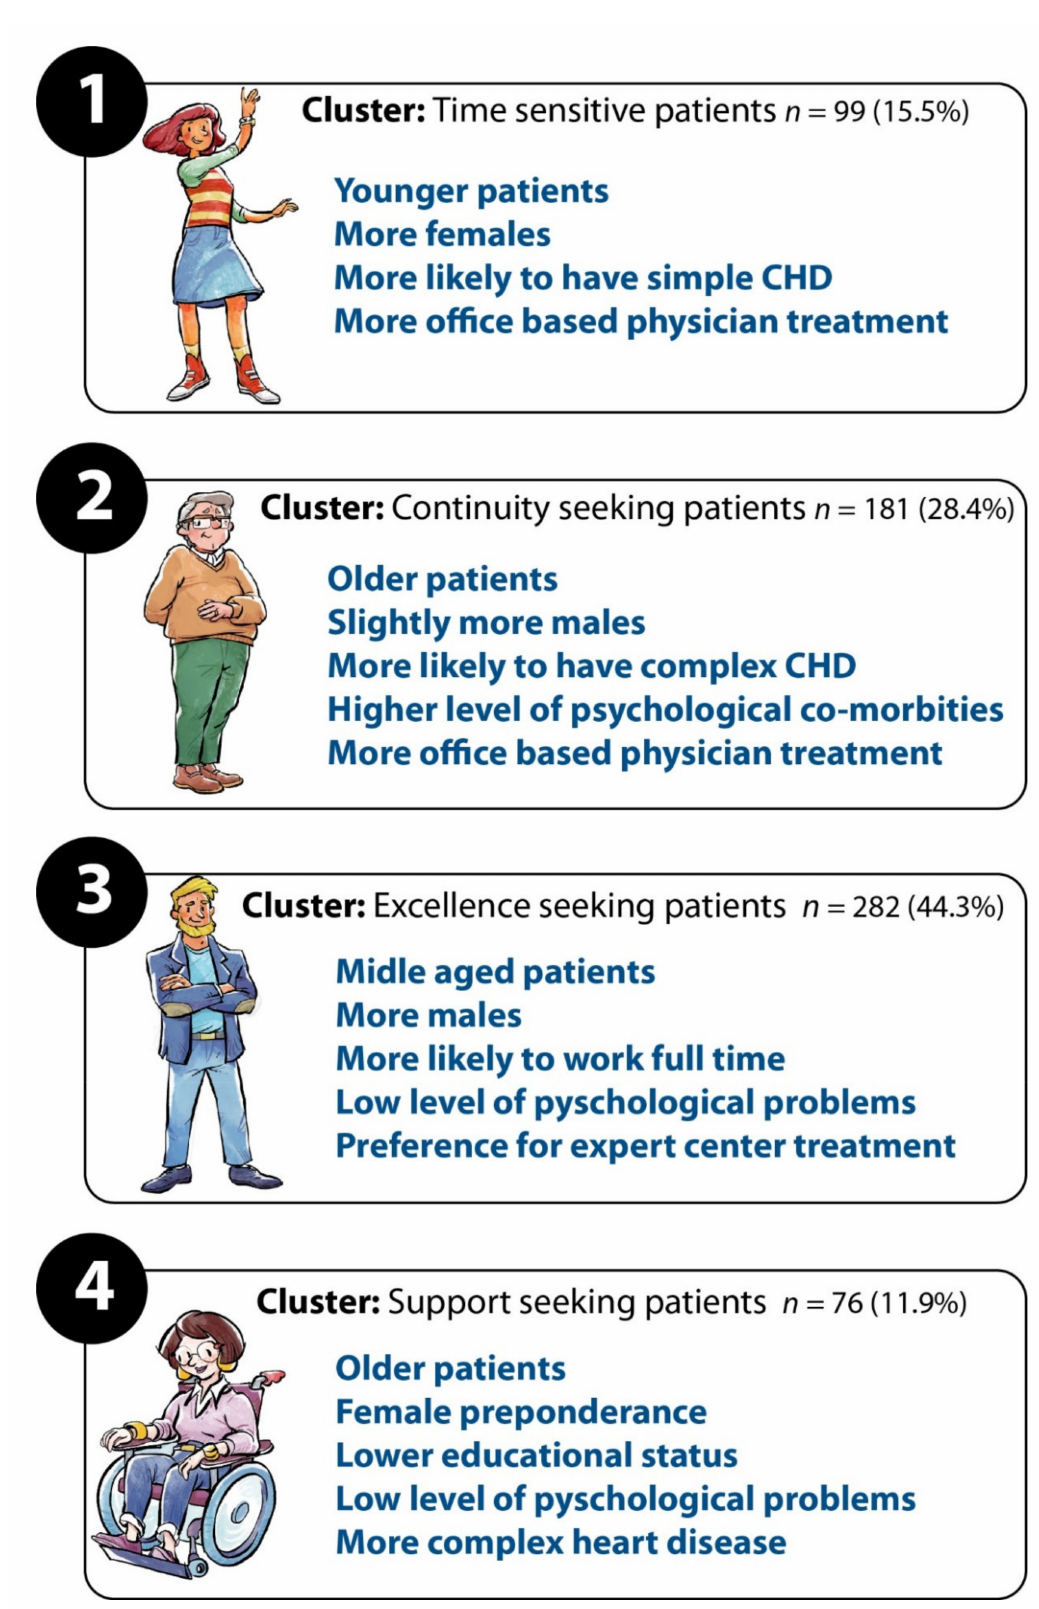
Figure 6. Overview over the four identified